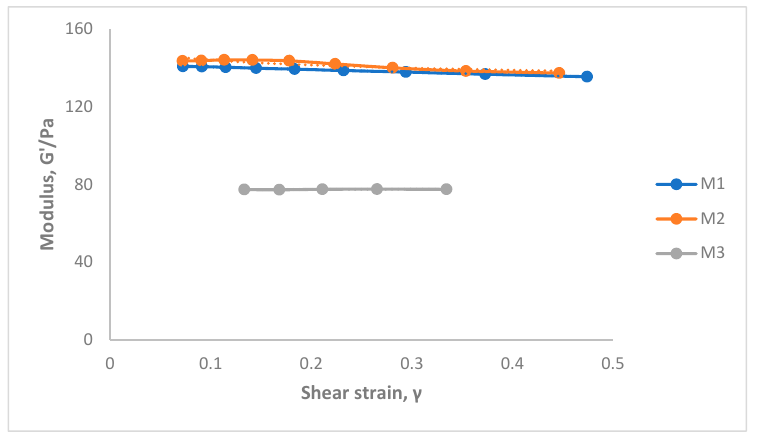
Figure 9. Amplitude strain sweep for hydrogels prepared with different concentrations of chitosan– BTC. (See Supplementary Tables S2–S4).